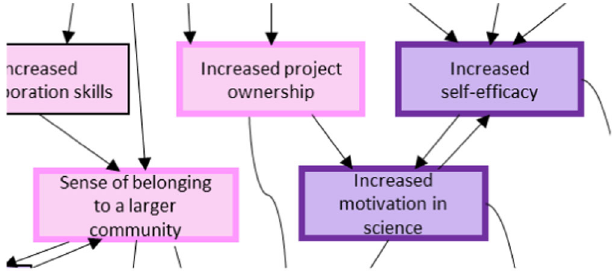
FIG. 8. A portion of Fig. 1, identifying the location of the CURE pathway model corresponding with our results (boxes outlined in bold). CURE researchers have identified increased self-efficacy as a probable outcome of CUREs and increased project ownership, sense of belonging to a larger community, and increased motiva- tion in science as possible CURE outcomes